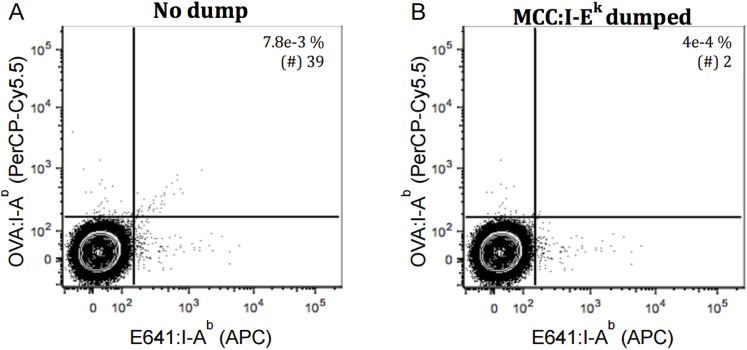
Dump tetramer and two-color analysis excludes the bulk of false positives from the analysis. TCR negative 58α-β- cells were incubated with E641: I-Ab, OVA: I-Ab and MCC: I-Ek tetramers as in Figure 4. Contour plot showing 58α-β- cells staining with E641: I-Ab (APC) and OVA: IAb (PerCP- Cy5.5) pre and post using dump (MCC: I-Ek) tetramer (A-B) Quadrant gate as in Nelson, et al., 2015. 500,000 58α-β- events are displayed. Percent and number of within the quadrant gates are shown in inset.